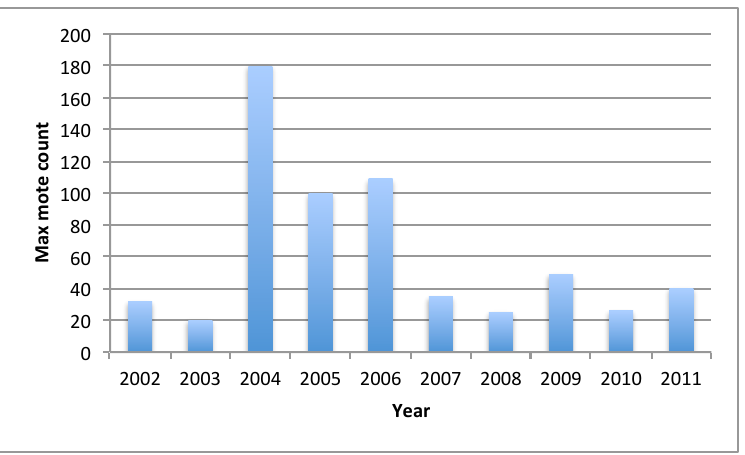
Figure 2. Maximum mote count in surveyed deployments, in each year — peak size in the years 2004–2006; over 100 motes used.